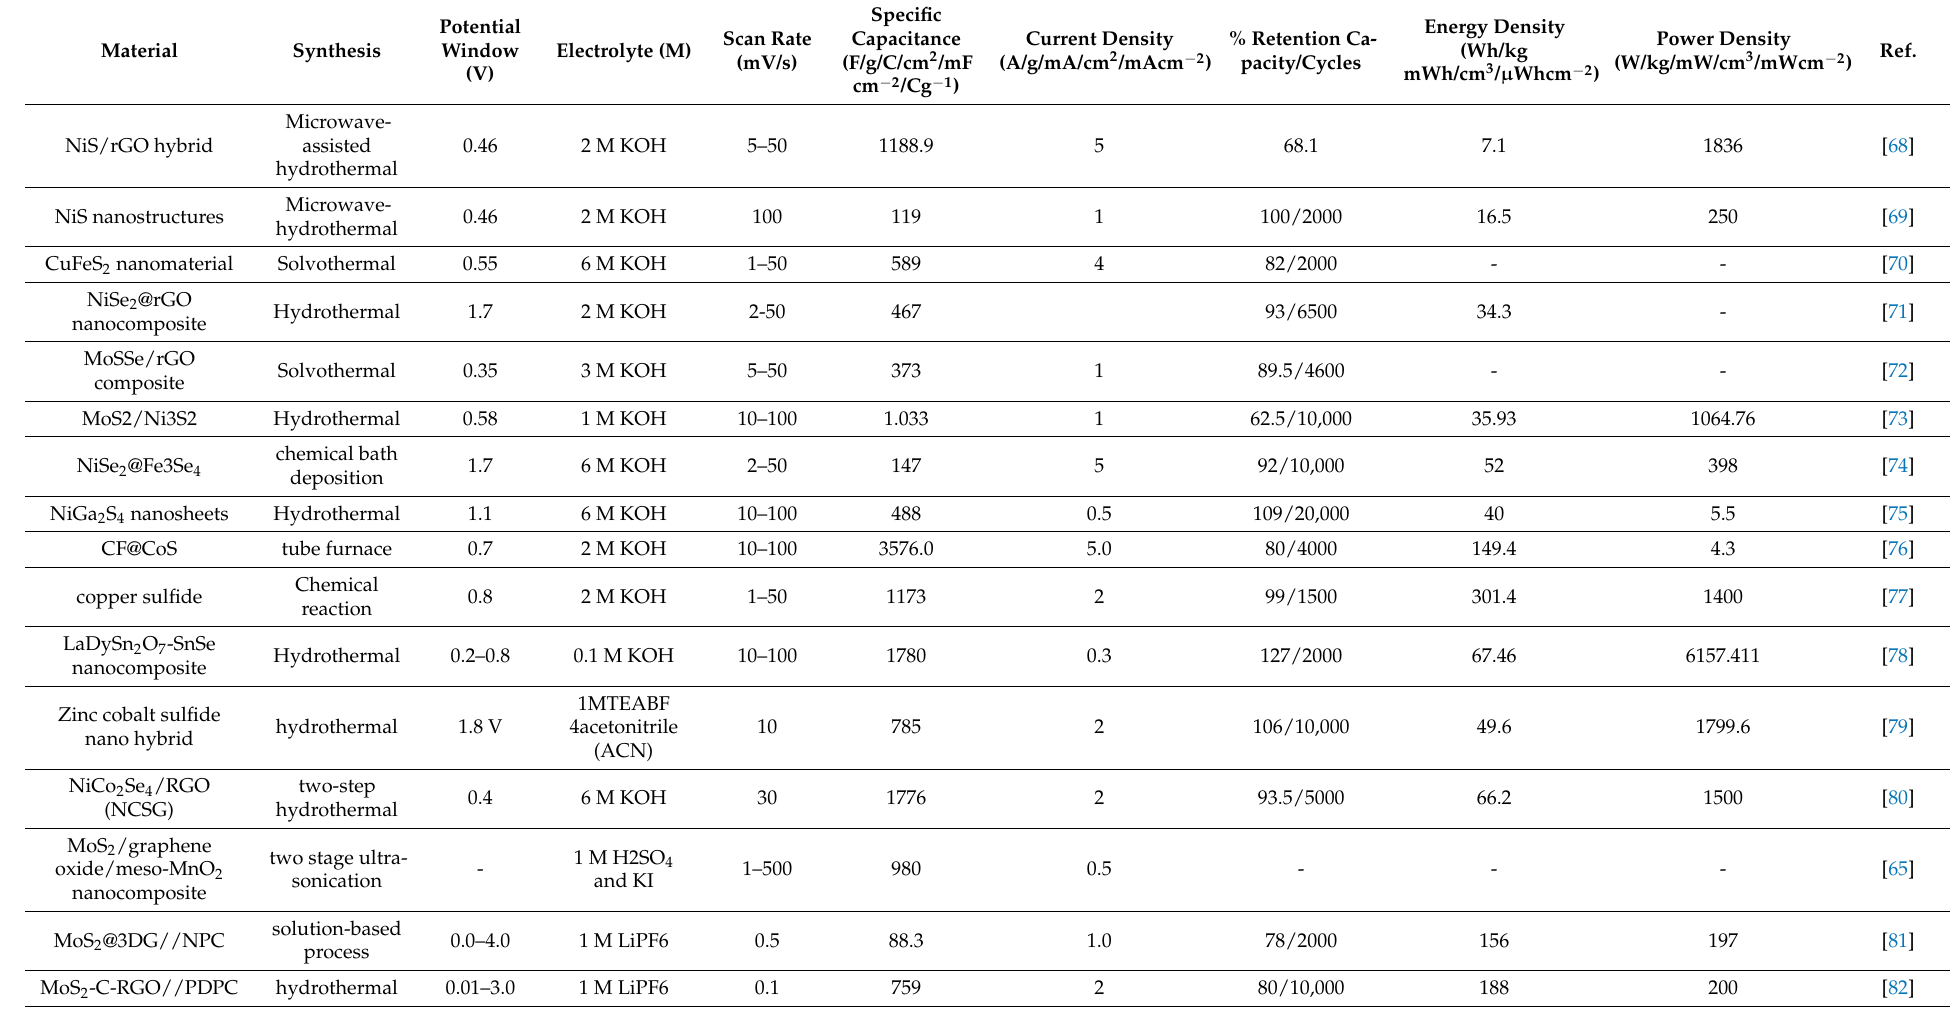
Table 1. Chalcogenides for